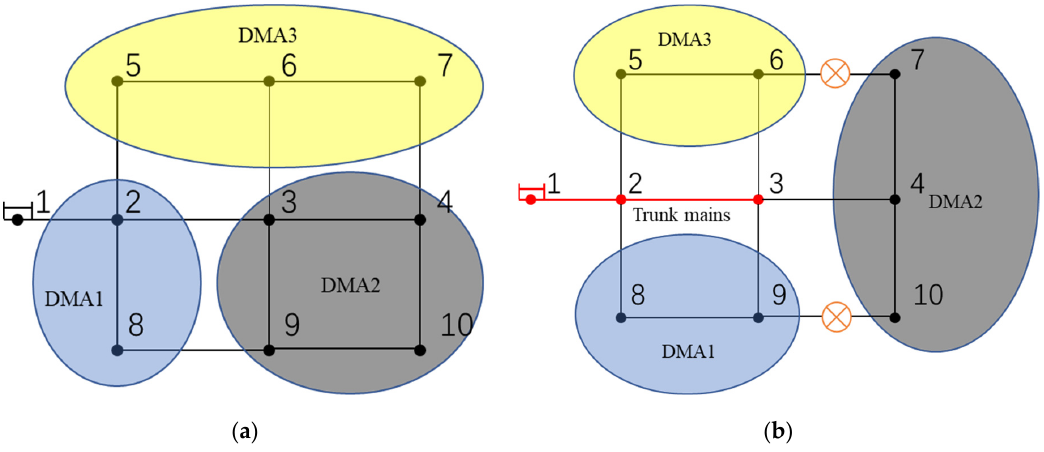
Figure 1. The Schematic diagrams of Schemes A and B: ( a ): Scheme A; ( b ): Scheme B.